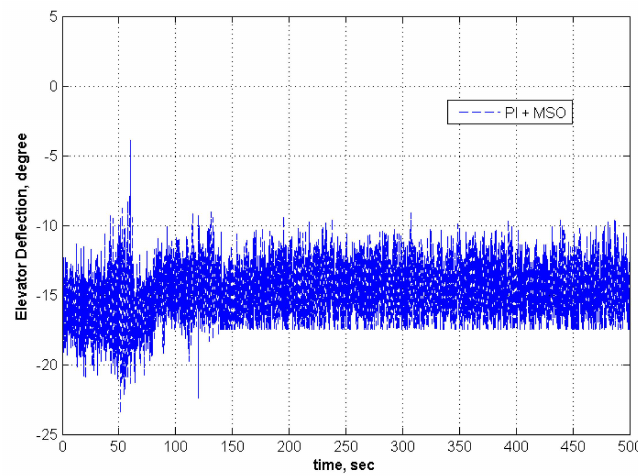
Figure 21. Elevator deflection for 50% C m α in the controller.